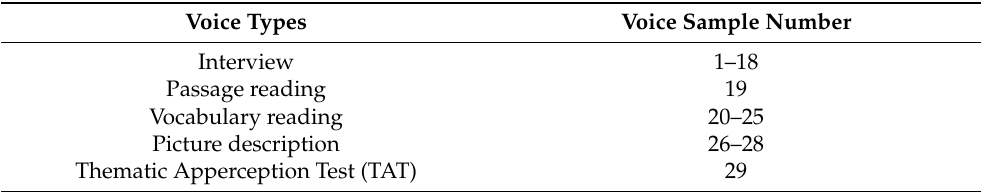
Table 1. Voice sample